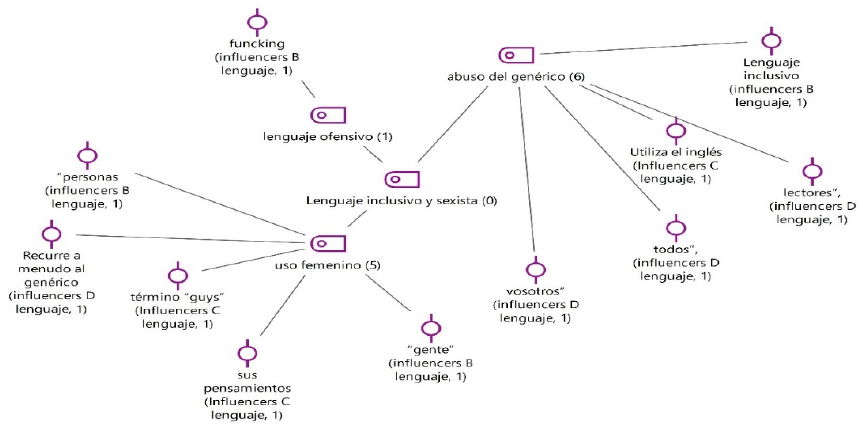
Figure 3. Categories and codes: Sexist or inclusive language. 5